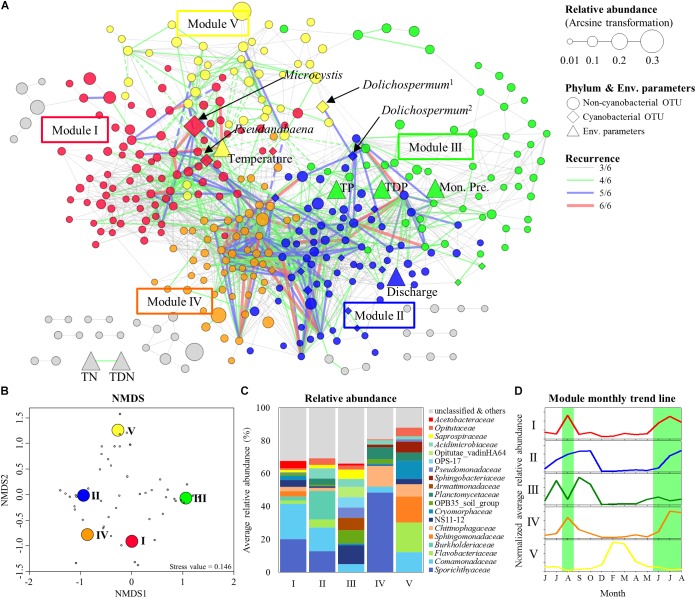
Modular structure of MRAN, comparison of nCCCs, and monthly patterns of the modules. (A) MRAN (≥3/6): node colors represent modules, Dolichospermum1 indicates OTU00013, Dolichospermum2 indicates OTU00035, solid lines represent positive correlations and dashed lines represent negative correlations. (B) NMDS of the top 50 genera in the major modules. (C) Average relative abundances of non-cyanobacterial OTUs in the major modules. (D) Trend lines representing the normalized average relative abundance of each major module: the green background represents Microcystis bloom periods.